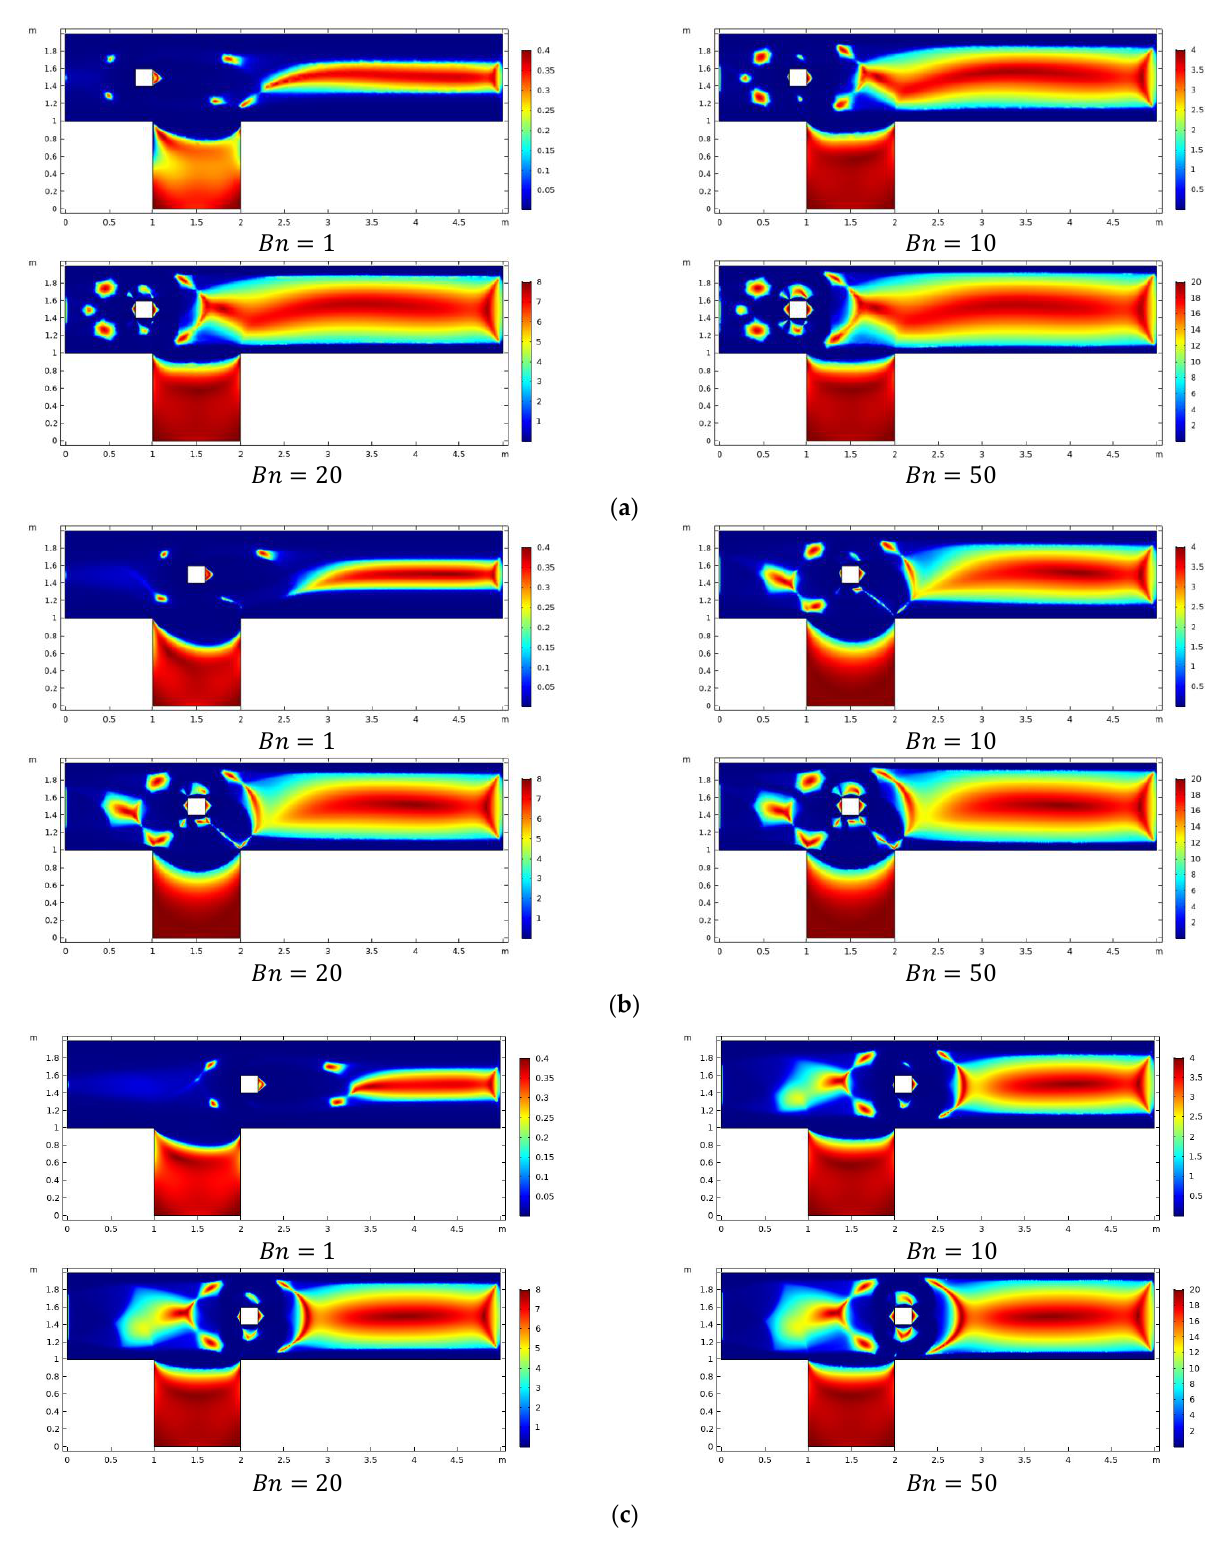
Figure 5. ( a ): Viscosity with the obstacle center at 𝐶 1 for various 𝐵𝑛 . ( b ): Viscosity with the center of obstacle at 𝐶 2 for various 𝐵𝑛 . ( c ): Viscosity with the center of obstacle at 𝐶 3 for various 𝐵𝑛 .